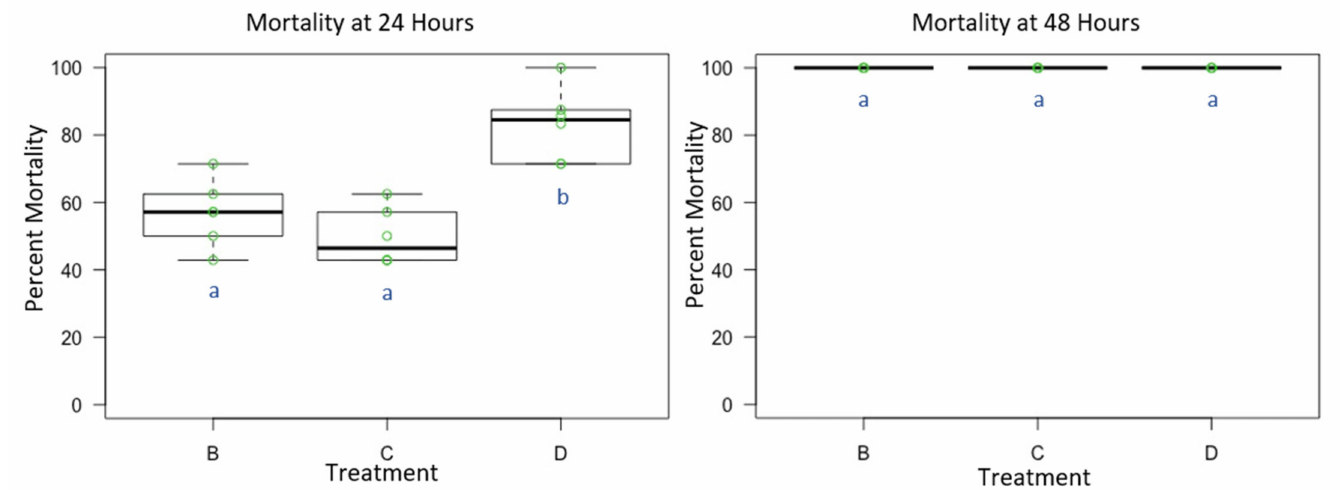
Figure 3. Male Osmia lignaria Acute Contact Toxicity Following Whole-Body Contact Exposure to Individual Active Ingredient Insecticides and their 1:1 Binary Combination: Male Osmia lignaria mean, 1st and 3rd quartile percent mortality following whole-body contact exposure to each individual active ingredient insecticide (Experiment 3) at 24 and 48 h. Data on the x-axis indicate each insecticide treatment, and data on the y-axis indicate percent mortality. Insecticide treatments: B = I, C = BC, D = IBC. All jars in a treatment containing the respective percent mortality are represented by a single green point. Significant difference at p < 0.05 (pairwise comparison) is indicated by different letters (a, b). Information related to control mortality is given in the result